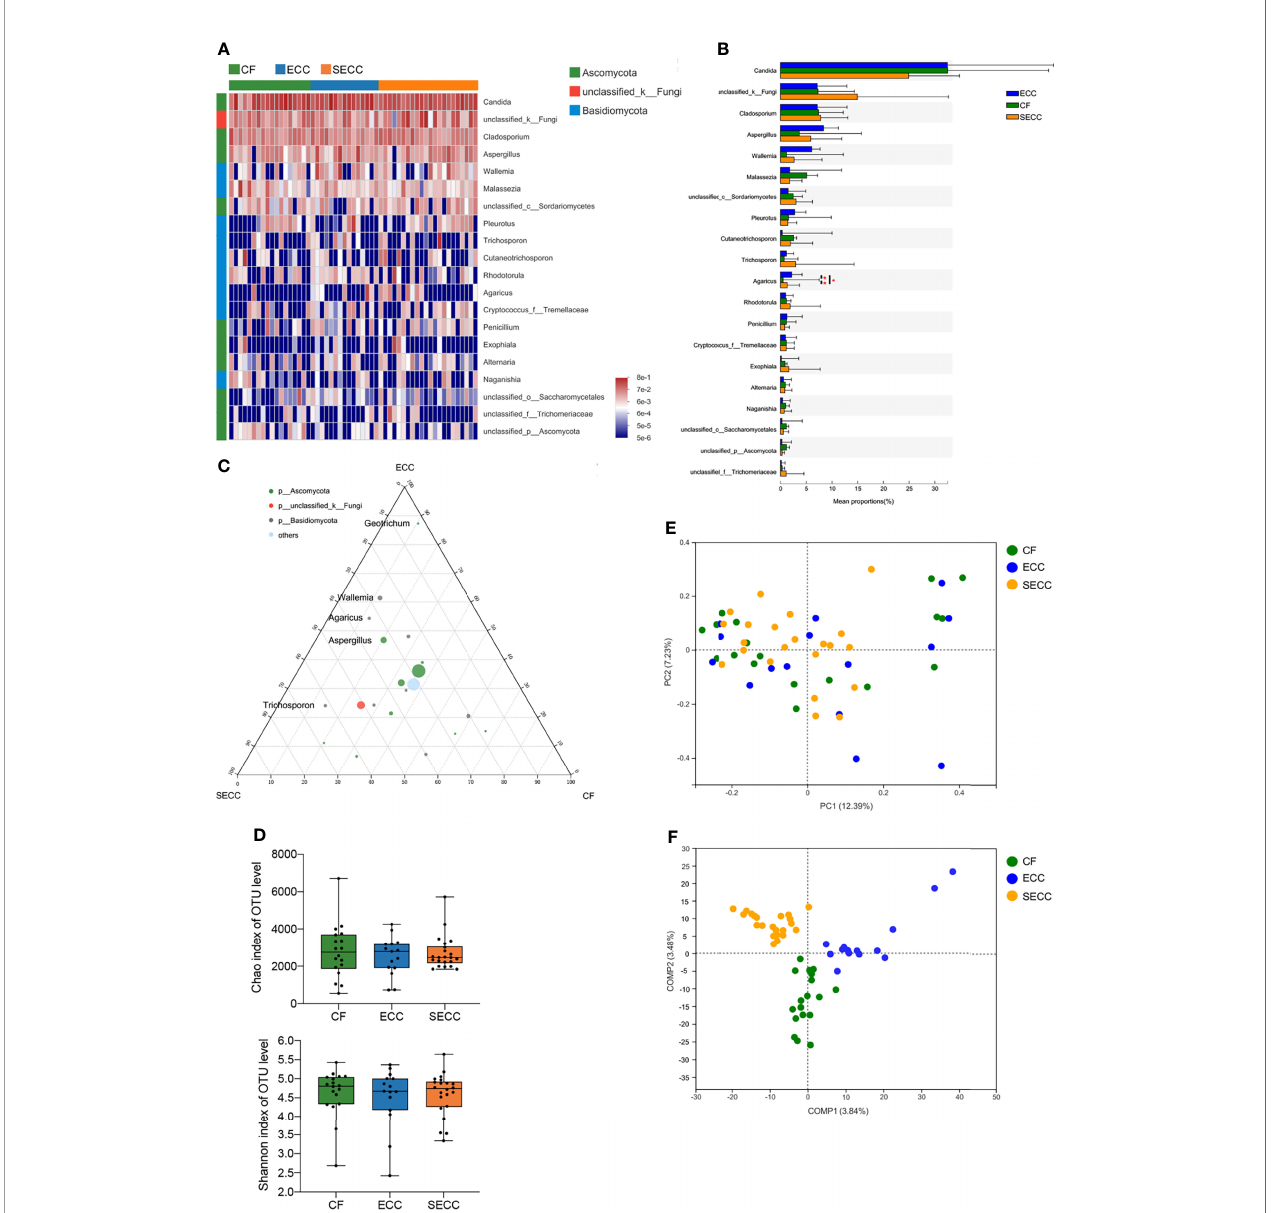
FIGURE 2 | Salivary fungal pro fi le in children with different health conditions. (A) Overview of the 20 most abundant salivary genera, and the heatmap presents the common logarithm of relative abundance. (B) Statistical comparison of the relative abundance of the 20 most abundant genera (Kruskal – Wallis, among three groups; Wilcoxon rank-sum test, within two groups; * p < 0.05). (C) The relative occurrence of genera (circles) in samples with different oral health conditions. (D) Alpha- diversity indices for richness (Chao index, Kruskal – Wallis, p = 0.886) and diversity (Shannon index, Kruskal – Wallis, p = 0.823) of the fungal community on the OTU level. (E) PCoA plots of Bray – Curtis dissimilarities at the OTU level (PERMANOVA, p = 0.304). (F) PLS-DA plot of saliva microbiota. CF, caries free; ECC, early childhood caries; OTU, operational taxonomic unit; PCoA, principal coordinates analysis; PERMANOVA, permutational multivariate analysis of variance; PLS-DA, partial least square discriminant analysis; SECC, severe early childhood